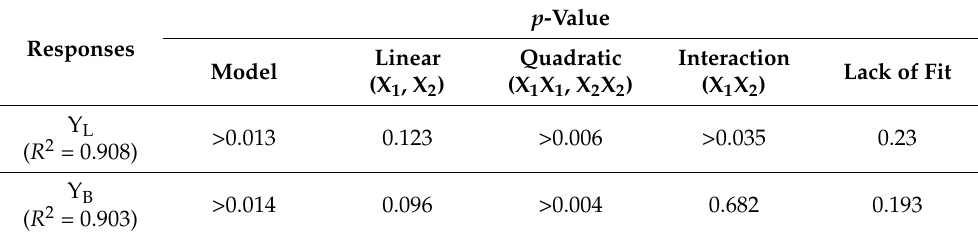
Table 3. Analysis of variance for the response of dependent variables during optimization of superheated treatment of chicken products: X 1 , temperature; X 2 , time; Y L , overall acceptance of chicken leg; Y B , overall acceptance of chicken